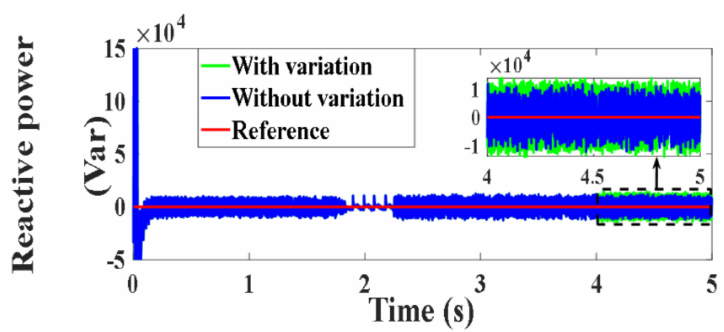
Figure 116. Reactive power under PVC